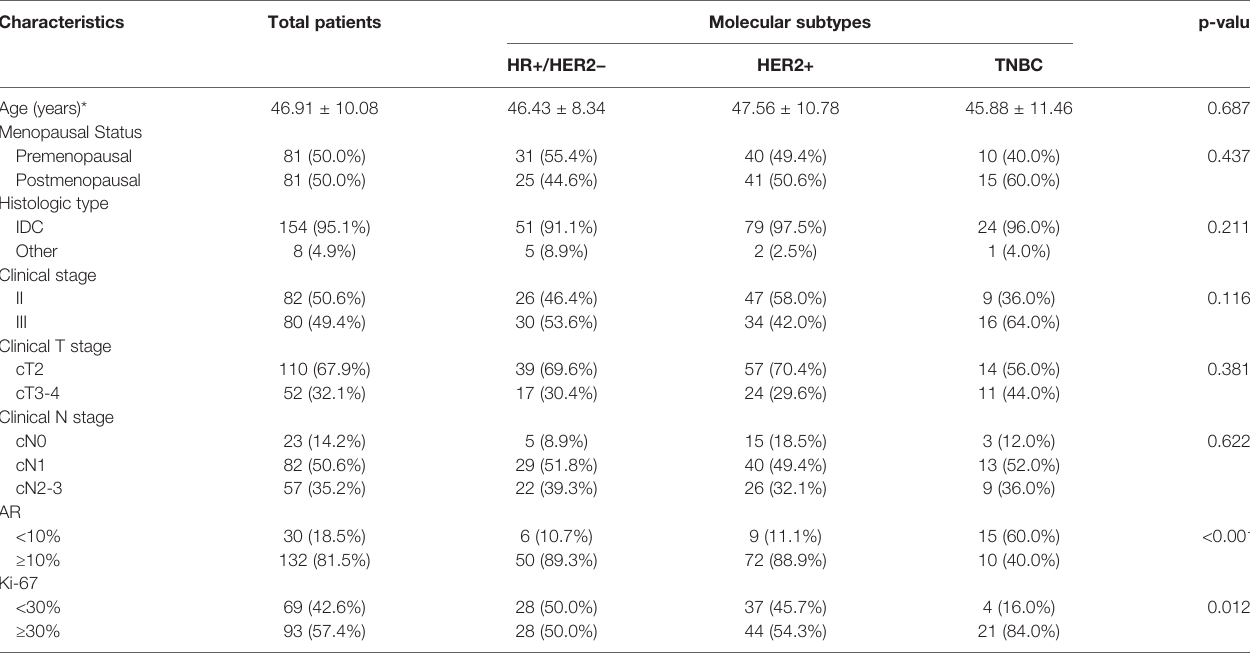
TABLE 3 | Clinical and histopathologic characteristics of patients grouped by molecular